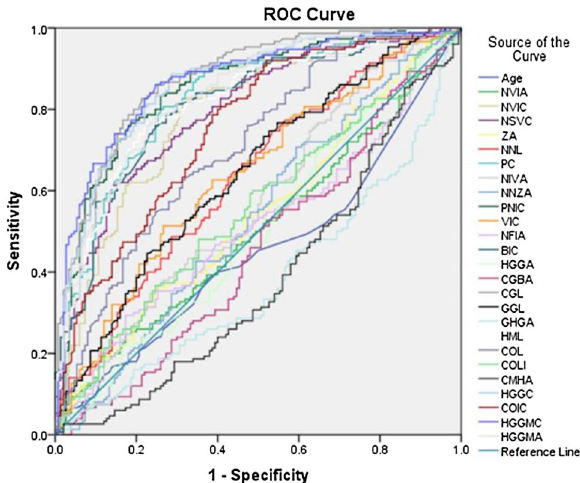
Figure 1. ROC curve.